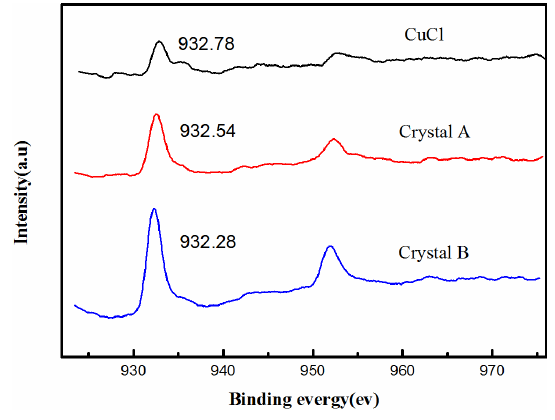
Figure 8. XPS spectra of Crystals A, B and CuCl for Cu 2p.